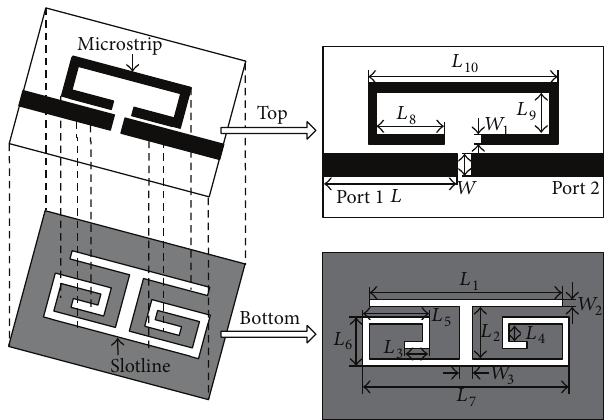
Figure 1: Configuration of slotline-microstrip triple-mode BPF.